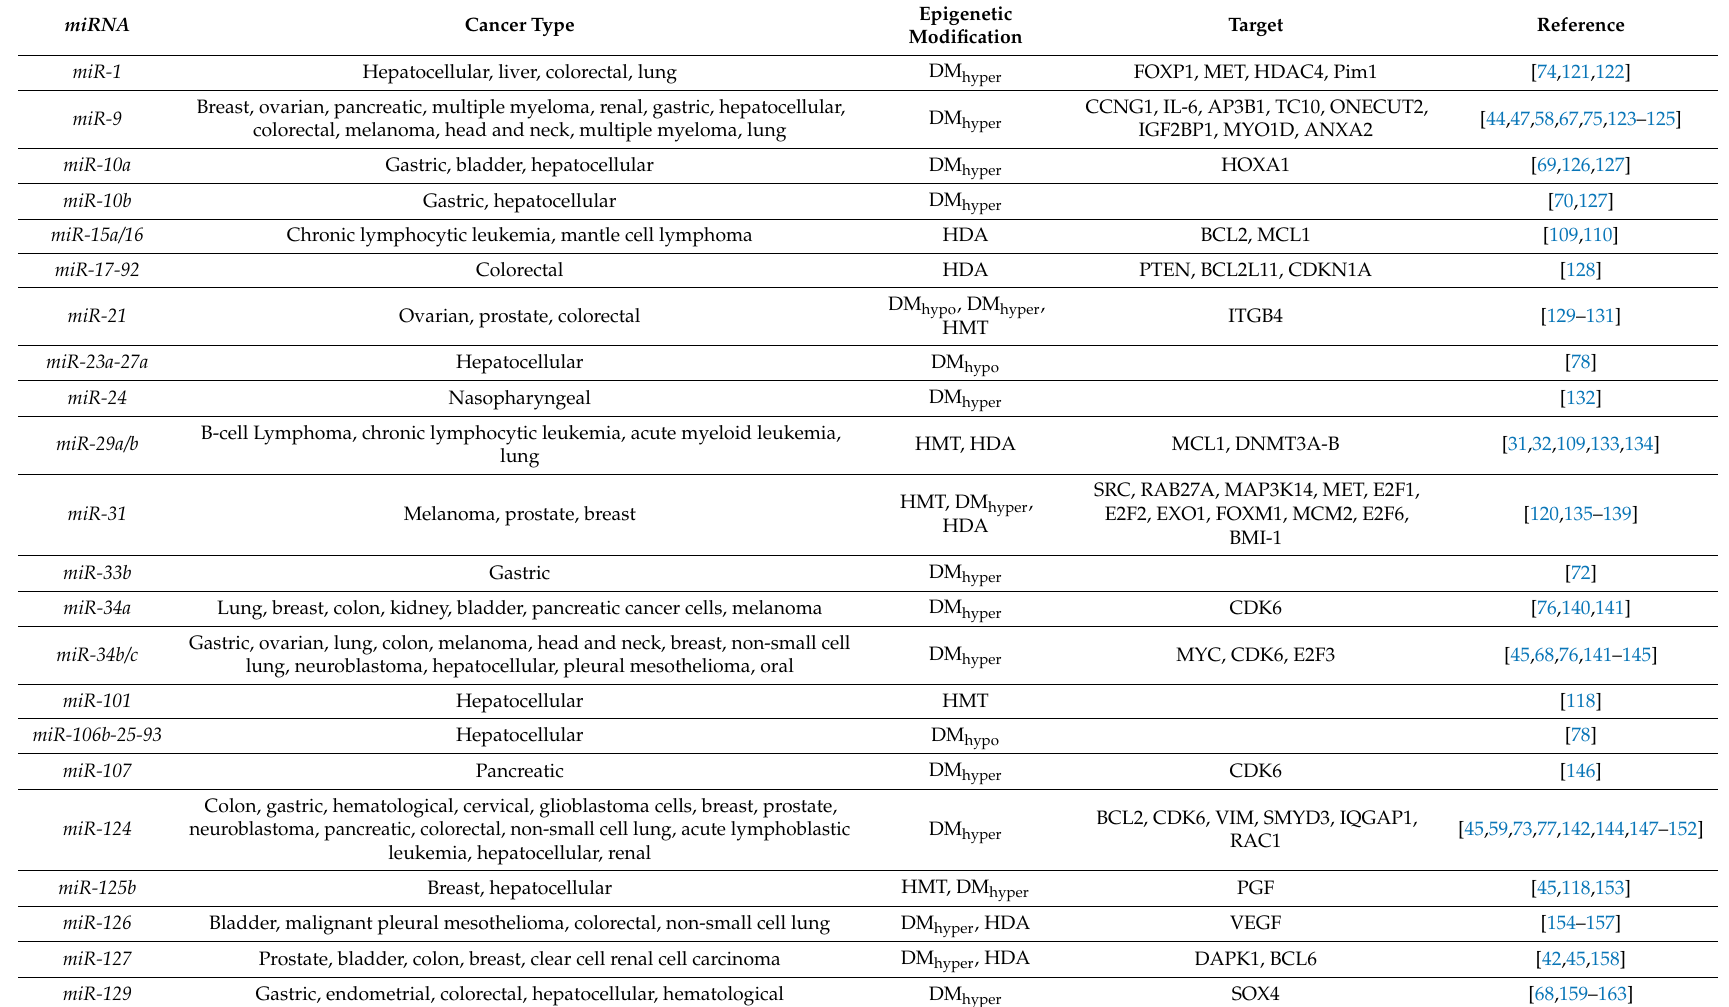
Table 1. Epigenetically regulated miRNAs in human